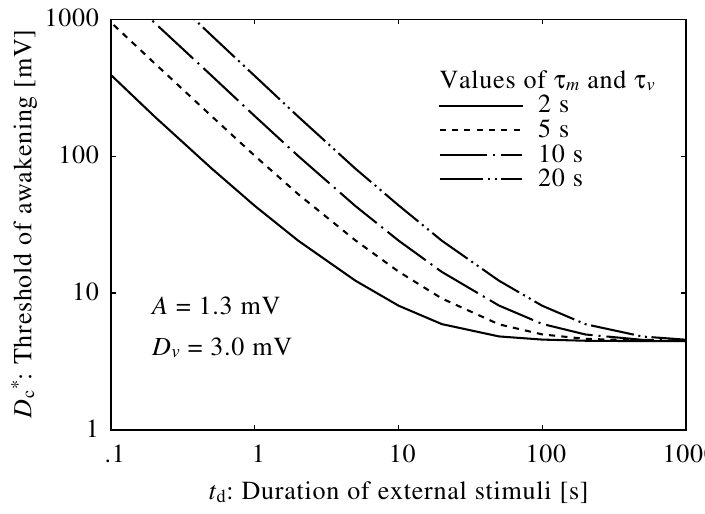
Figure 6. Relationship between neuroelectrical thresholds of awakening in response to external stimuli and the duration of the external stimuli using different values of τ m and τ v .